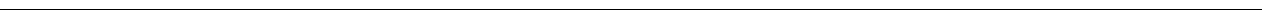
Fig. 2 Structure-based sequence alignment of the DotM family of proteins. The sequence of DotM from L. pneumophila is aligned to its closest homologs from Fluoribacter dumof fi i , Rickettsia grylli , and Coxiella burnetii (77%, 43%, and 38% identity, respectively), as well as other DotM homologs from Piscirickettsiaceae bacterium , Methylibium petroleiphilum , and Candidatus Burkholderia . TrbA from R64/IncI conjugation plasmid is also aligned, although its identity is much lower (23%). Highly conserved, strongly conserved, and conserved residues are indicated by dark blue, purple, and lavender, respectively. Residues mutated at this study indicated by an asterisk, and those found to participate in effector binding in L. pneumophila are boxed. The secondary structure elements are indicated as observed in the crystal structure (blue cylinders) or predicted transmembrane helices (red cylinders). Secondary structure elements and amino acid numbering at the top of the sequence refer to DotM from L.